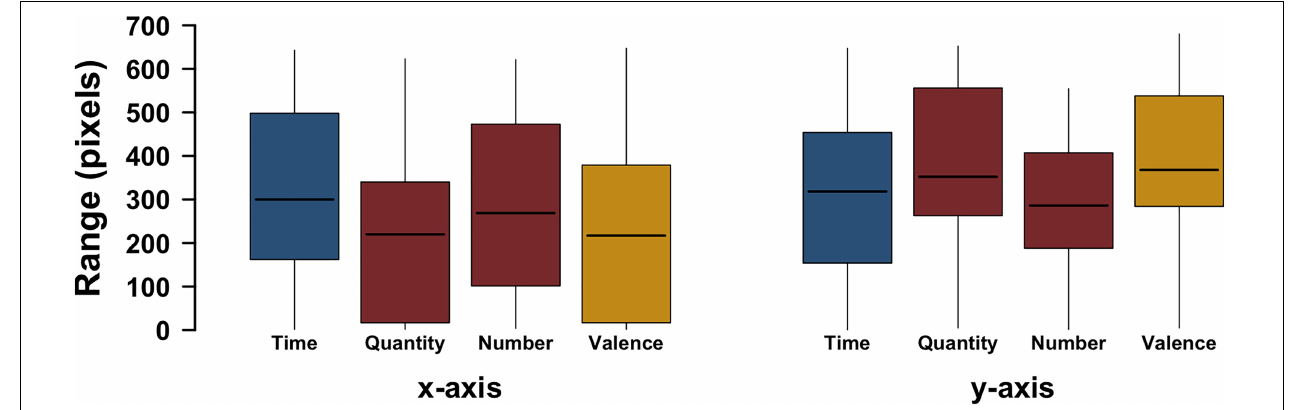
FIGURE 6 | Range of responses (smallest to largest) along the x -axis and the y -axis for each of the tasks; whiskers represent the largest/smallest number within 1.5 times the interquartile range extending from the